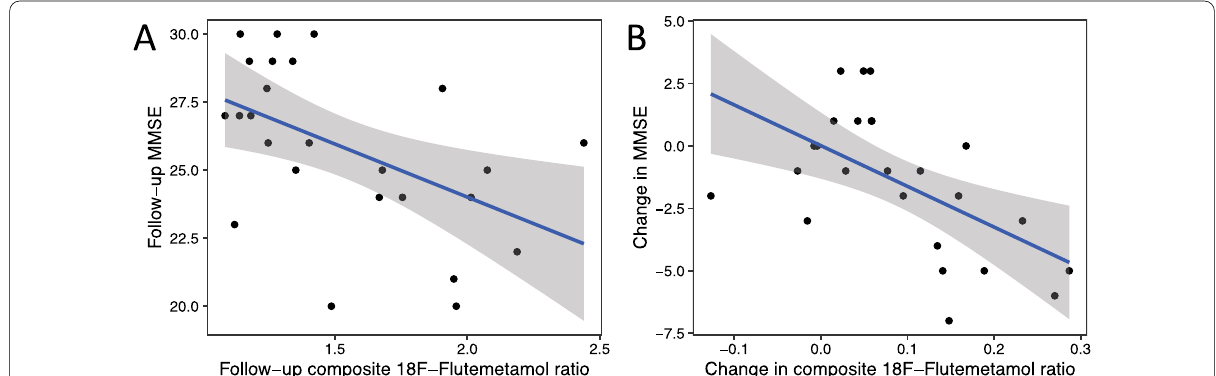
Fig. 2 Composite 18F-Flutemetamol uptake ratio and MMSE score were negatively associated at follow-up ( A ), and in terms of change over time from baseline to the end of follow-up ( B